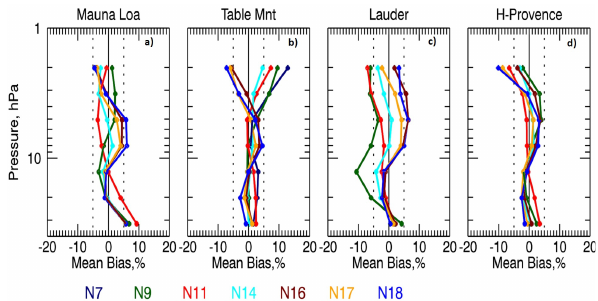
Fig. 7. Same as Fig. 6 only relative to coincident ground-based lidar measurements at (a) Mauna Loa, (b) Table Mountain, (c) Lauder and (d) Haute Provence. Colors correspond to individual SBUV in-